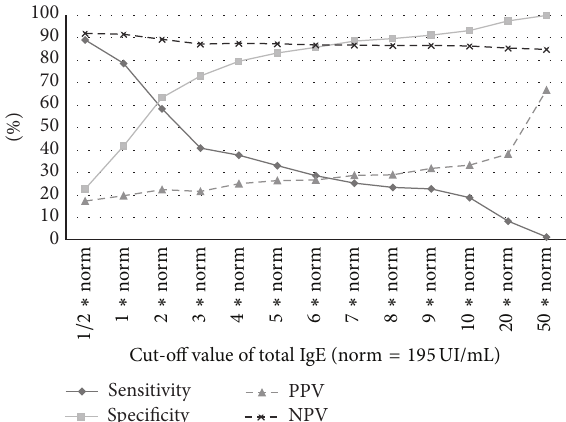
Figure 4: Diagnostic significance of different cut-off values of total IgE in screening for multiple allergens in patients with an already detected